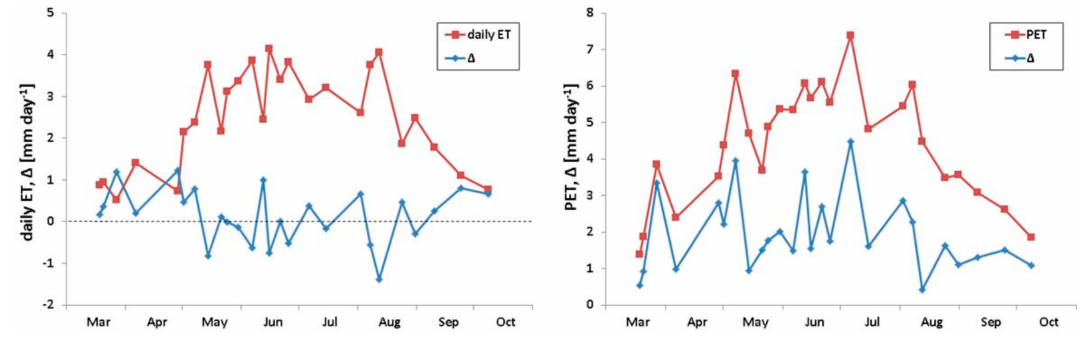
Figure 7. ET estimates and ∆ [mm day − 1 ] for the proposed method ( left ) and standard PET ( right